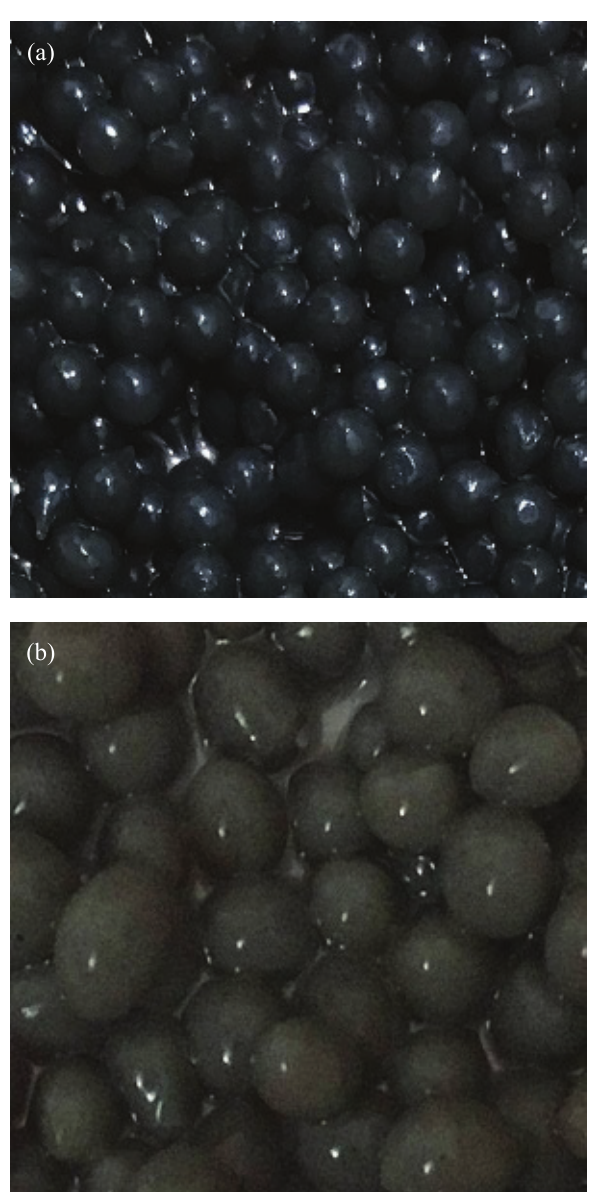
Fig. 1 – Bacterial cells immobilized with; (a) SA, and (b)